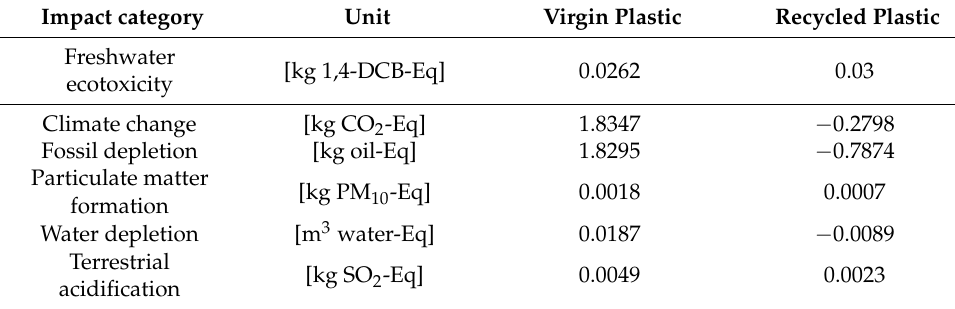
Table 5. LCIA results for both